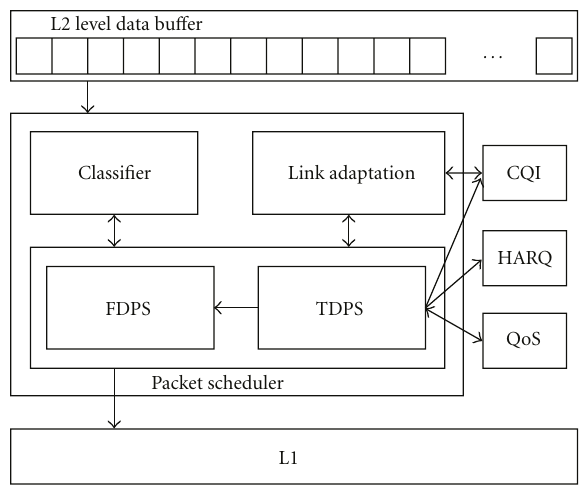
Figure 1: The structure of RT and NRT tra ffi c packet scheduler in